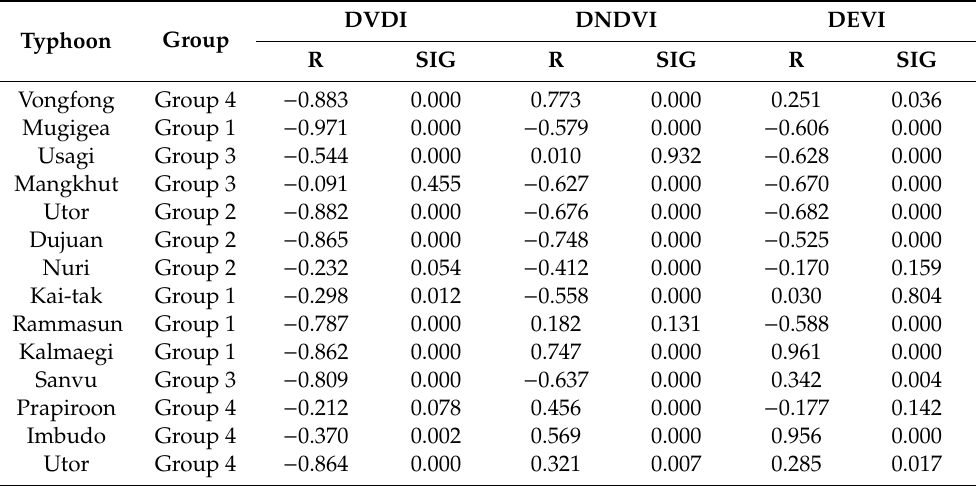
Table 3. Correlation analysis results of DVDI / DNDV / DEVI and area percentages of VD.